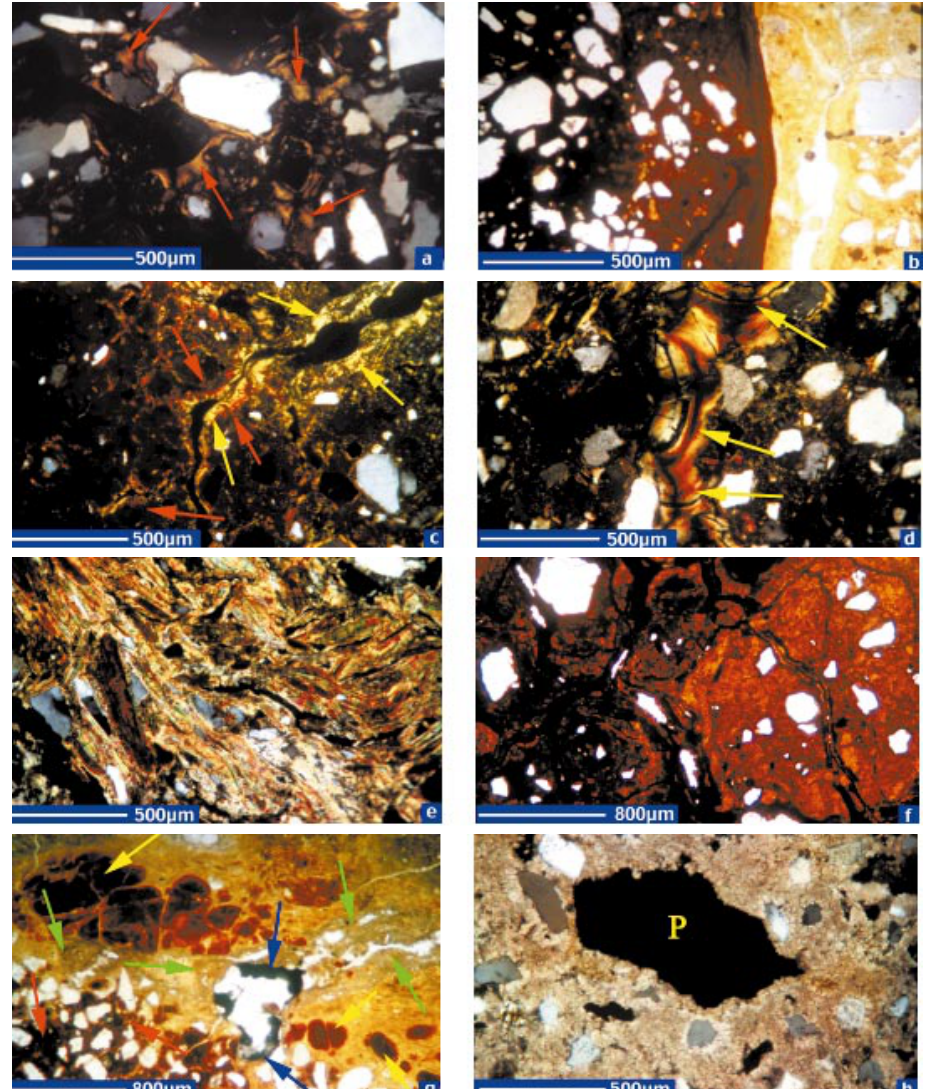
Figura 5. Fotomicrografias: (a) Perfil 1, horizonte Bt1. Argila iluvial (setas vermelhas) preenchendo parcialmente poros dos tipos cavidade e canal, com forte manifestação de anisotropia ótica de forma e extinção. (XPL). (b) Perfil 1, horizonte Btf1. Nódulo concrecionário de ferro contendo materiais grosseiros similares aos da matriz do solo. Observa-se o núcleo mais escuro, clareando em direção à periferia. (PPL). (c) Perfil 1, horizonte Btf1. Canal com domínios de argila apresentando intensa manifestação de anisotropia ótica de forma. A presença de pseudomorfos de biotita, liberando ferro (setas vermelhas), nas proximidades e a condição destes ditos revestimentos parecerem situados mais na matriz do solo (setas amarelas) do que como reais revestimentos ou preenchimentos do poro, conduzem à interpretação dos mesmos como argilãs de intemperização e não de iluviação. (XPL). (d) Perfil 1, horizonte Btf1. Canal com preenchimento de argila de natureza iluvial. Observam- se microlaminações crescentiformes (setas amarelas), características de alternância entre iluviações de argilas silicatadas e oxídicas, em uma típica disposição argilãs/ferrãs (Brewer, 1975). (XPL). (e) Perfil 2, horizonte Bt. Biotitas em vários estágios de intemperização. Muitas dessas biotitas apresentam-se deformadas, provavelmente como resultado de atividades de expansão e contração da massa do solo. (XPL). (f) Perfil 2, horizonte Bt4. Forte impregnação de ferro nas áreas de mosqueamento (contendo grãos de areia constituídos de quartzo) com coloração mais clara em direção às suas partes mais externas. (PPL). (g) Perfil 3, horizonte Btnz1. Manchas de mosqueados plínticos. Observam-se dois tipos de manchas: as mais escuras apresentam fragmentação e cores mais claras escurecidos, provavelmente por compostos orgânicos liberados pelo ataque de fungos às raízes. (PPL). (h) Perfil 3, horizonte Btnz3. Carbonato de cálcio reprecipitado, na forma de calcita